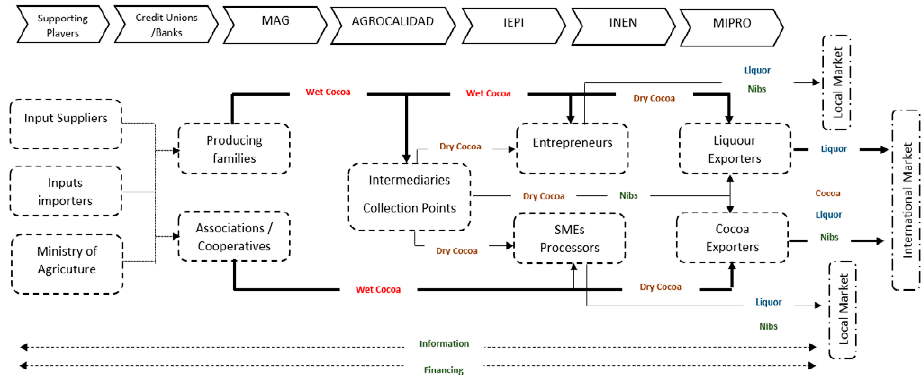
Figure 3. Mapping of the Cocoa Chain at Babahoyo District.